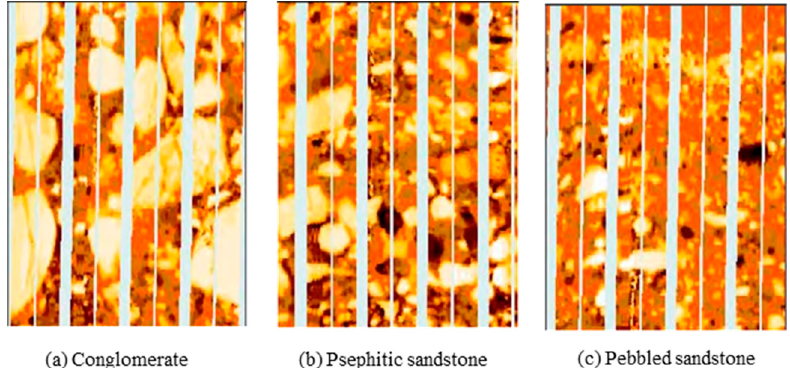
Figure 2. Formation MicroScanner images at different depths of a tight glutenite reservoir (Reproduced with permission from [2], Wang et al., Progress in Geophysics, 2019)